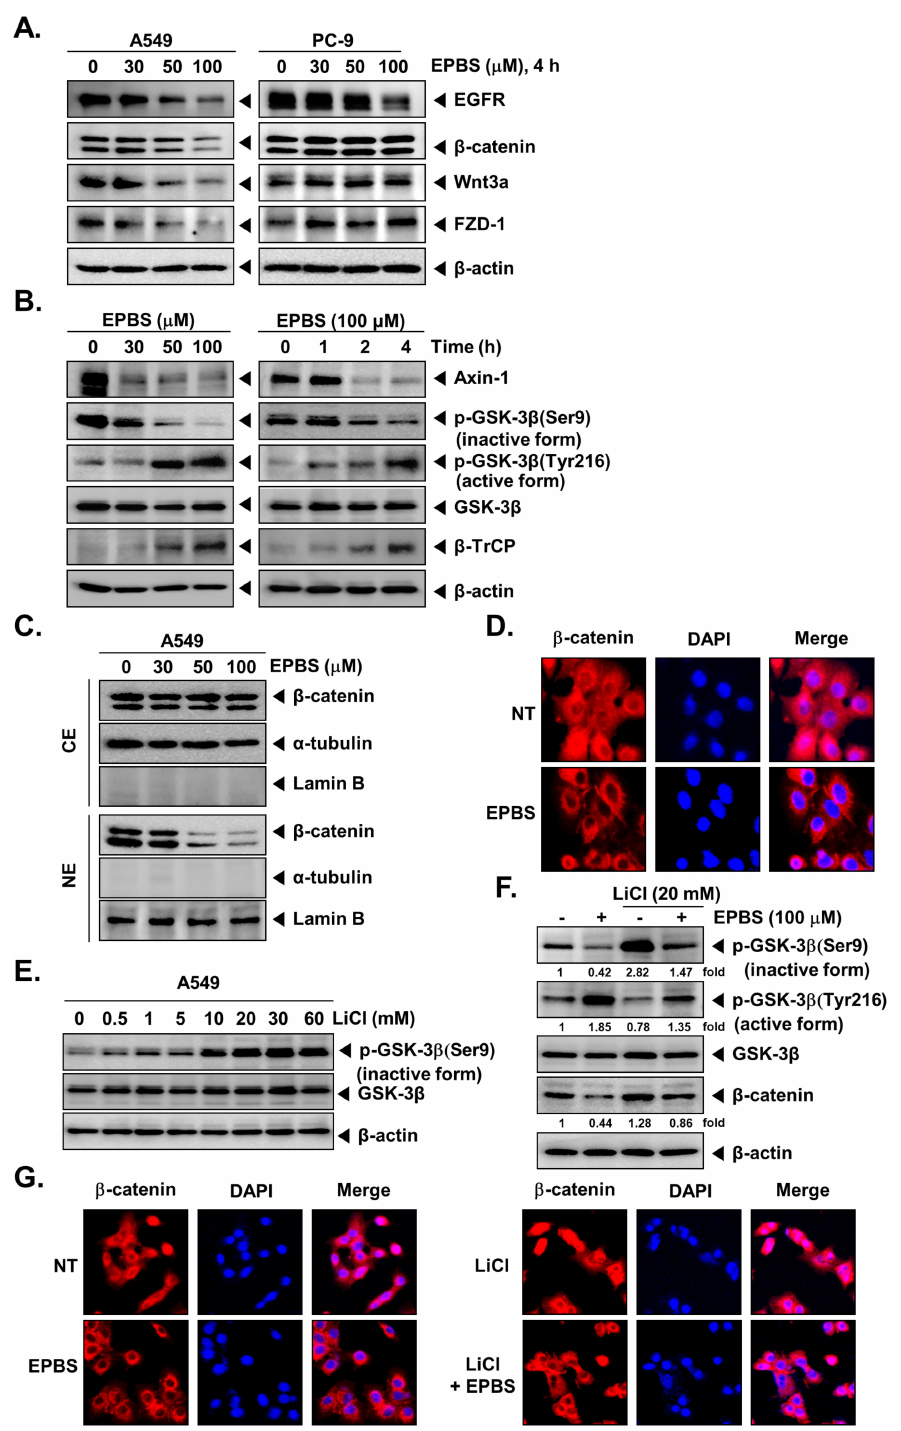
Figure 2. EPBS downregulates EGFR and the Wnt/ β -catenin pathway and decreases the nuclear pool of β -catenin. ( A ) A549 cells and PC-9 cells (5 × 10 5 cells/well) were treated with EPBS (0, 30, 50, and 100 µ M) for 4 h. Western blot analysis was performed. For confirming equal protein loading, the same blot membrane was stripped and re-probed with a β -actin antibody. ( B ) A549 cells (5 × 10 5 cells/well) were treated with the indicated concentration of EPBS for 4 h or with 100 µ M of EPBS for indicated time intervals. EPBS-treated cells were collected and lysed, and then an equal amount of lysates were detected by Western blot analysis. ( C ) EPBS (0, 30, 50, and 100 µ M for 4 h)-treated A549 cells (5 × 10 5 cells/well) were collected, and then cytoplasmic extracts (CE)